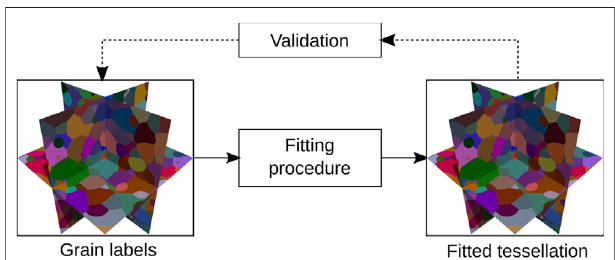
FIGURE2| Schematicoverviewofthe fi ttingoftessellationstosimulated imagedatahaving smoothgrainboundariesand validationoftheresulting fi ts. Orthogonal 2D slices through 3D datasets are shown.